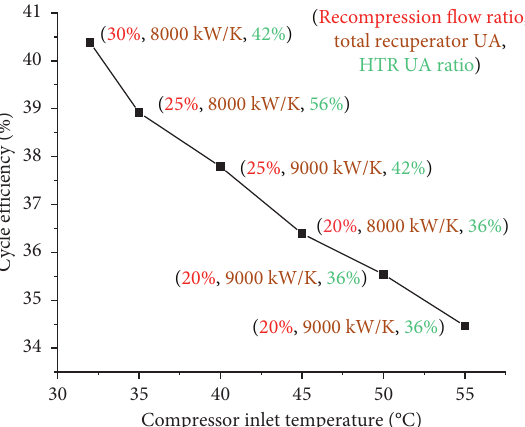
Figure 15: Effects of compressor inlet temperature on the cycle thermal efficiency for dry-cooled